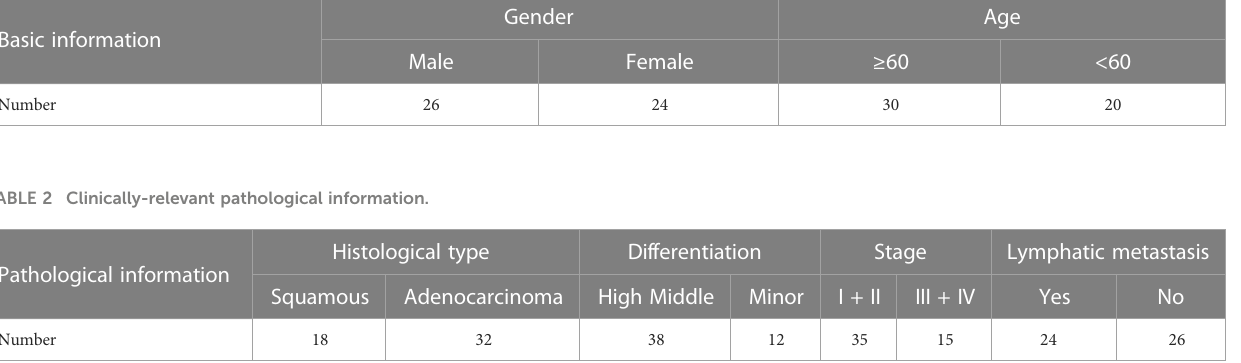
Basic information